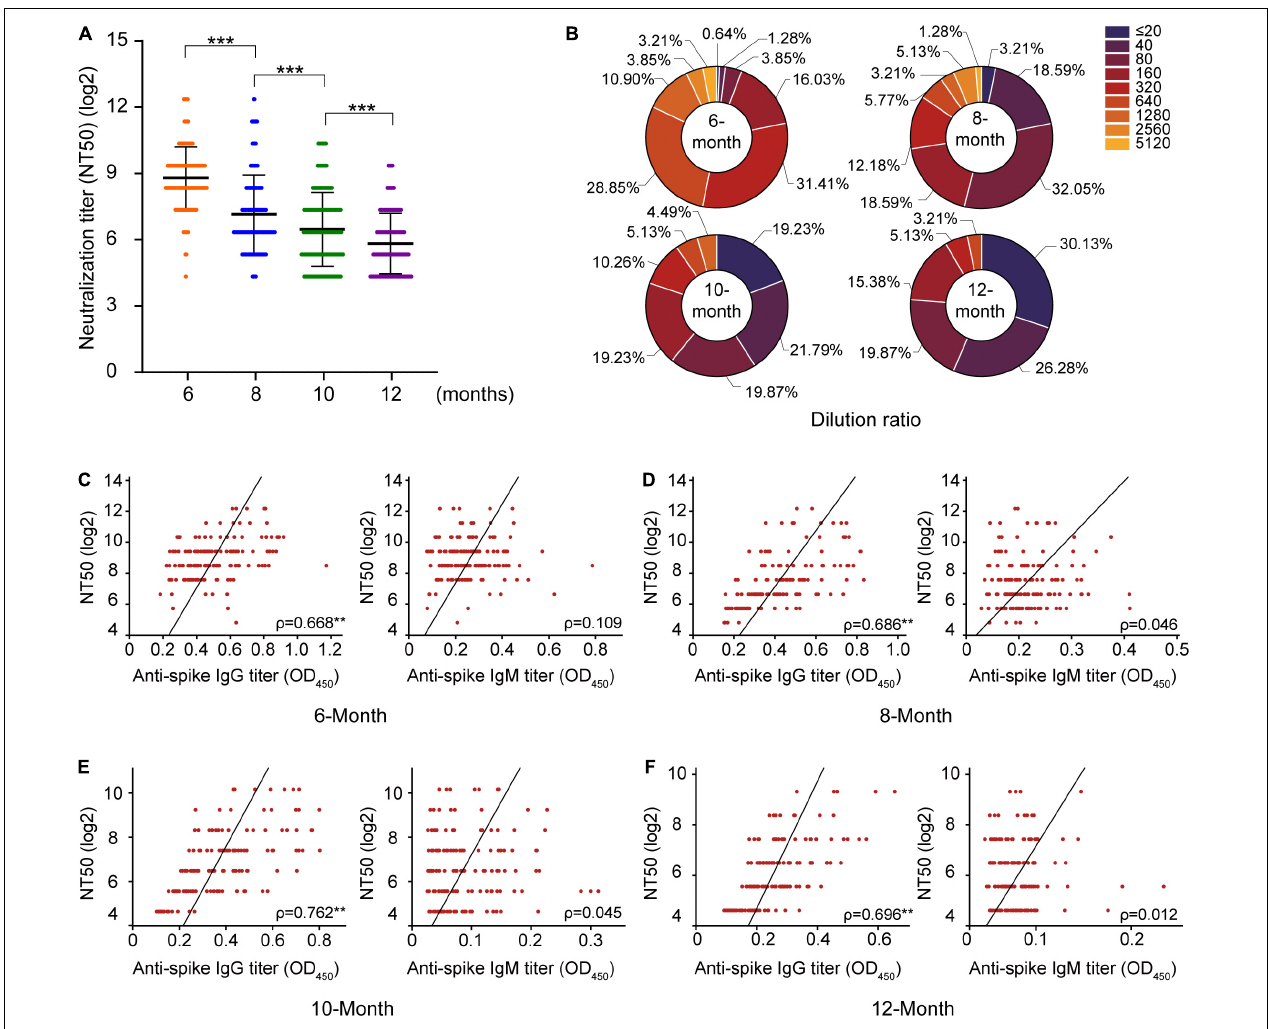
FIGURE 3 | Evaluation of the changes in neutralizing antibody titers in 156 serum samples. According to the classification at different time points after convalescence, (A) reflects the change in the neutralization titer of serum from convalescent patients, and the y -axis represents the log2 of the neutralization titer. (B) Reflects the change in the proportion of the neutralization titer in serum; (C–F) indicates the analysis of the correlations of S protein IgG and IgM with neutralizing antibodies, respectively. *** P < 0.001.